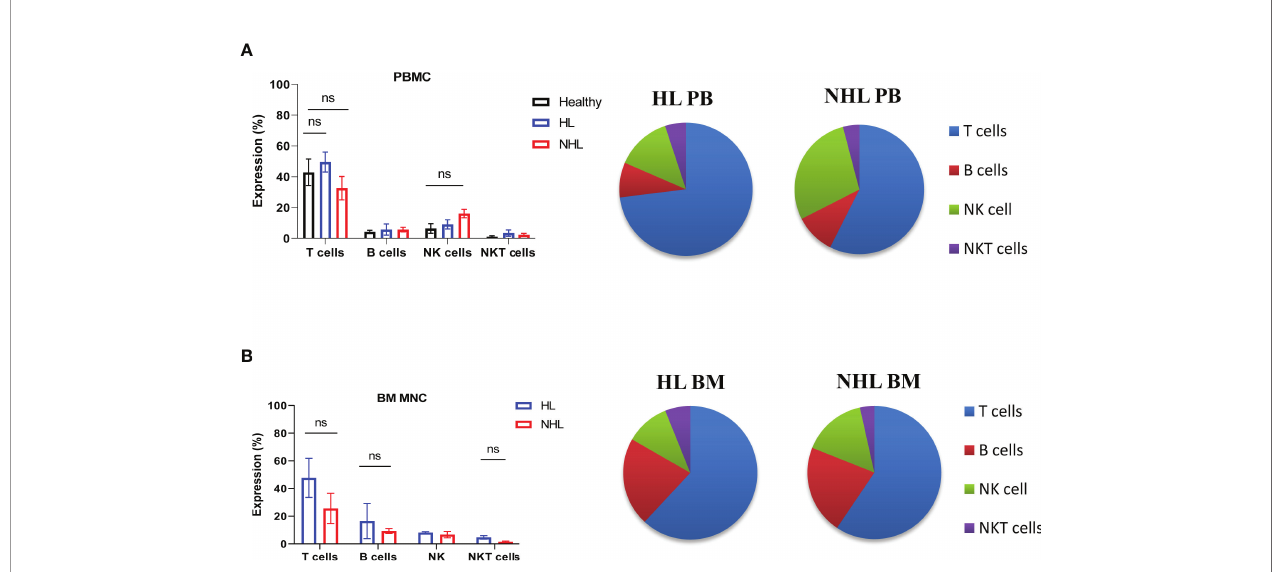
FIGURE 1 | Frequency of lymphocytes in peripheral blood and bone marrow samples derived from patients with HL and NHL patients. The percentage of T cells (CD3 + CD56 - ), B cells (CD3 - CD19+), NK cells (CD3 - , CD56 + ) and NKT cells (CD3 + CD56 + ) in peripheral blood (A) derived from HL, NHL patients and healthy controls and bone marrow samples (B) derived from HL and NHL patients. Graphs show mean ± SEM. ns, not signi fi cant. PB, peripheral blood; BM, bone